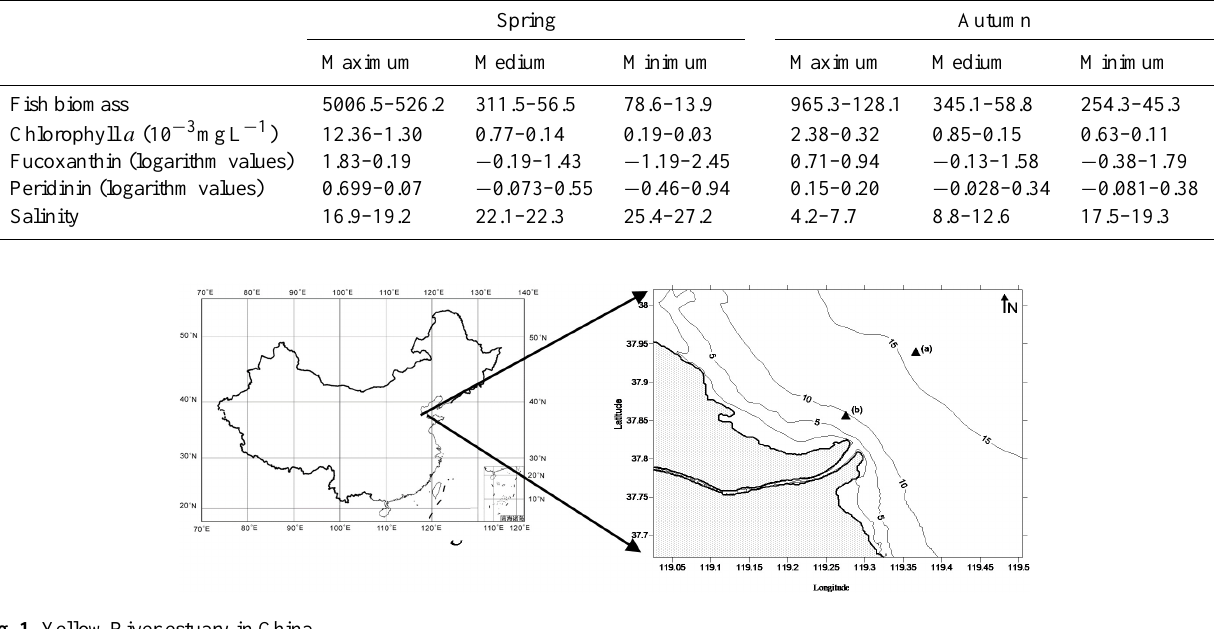
Fig. 1. Yellow River estuary in